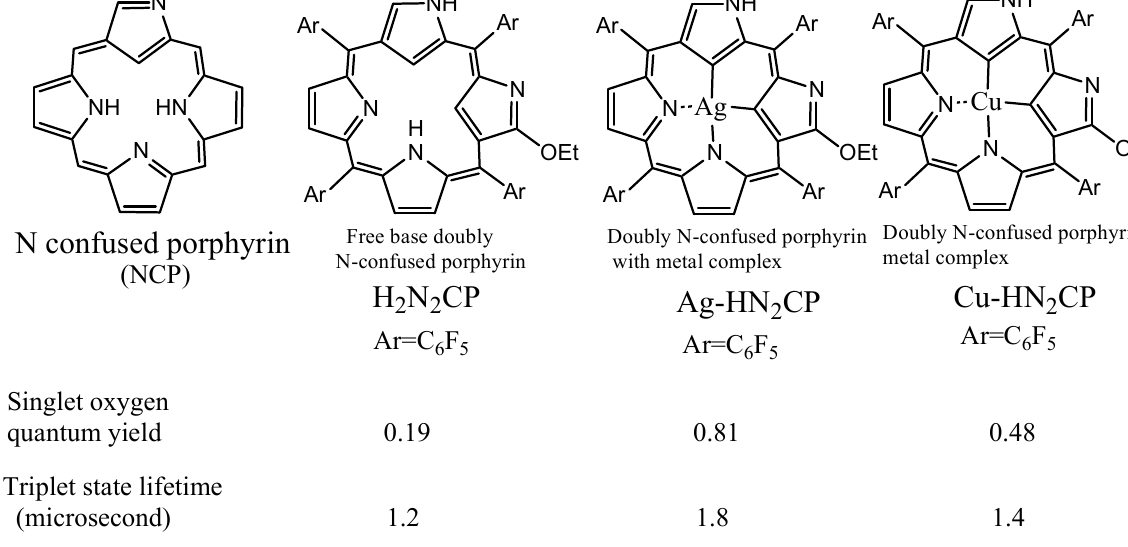
Figure 17. Properties of N-confused porphyrin (H 2 N 2 CP) with, and without, metal atoms.